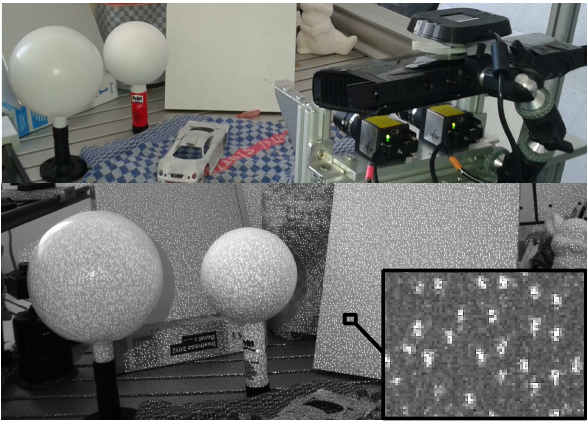
Figure 5: Evaluation setup (upper) and camera images (lower) with Kinect speckle pattern. Lower right image: magnified image detail.